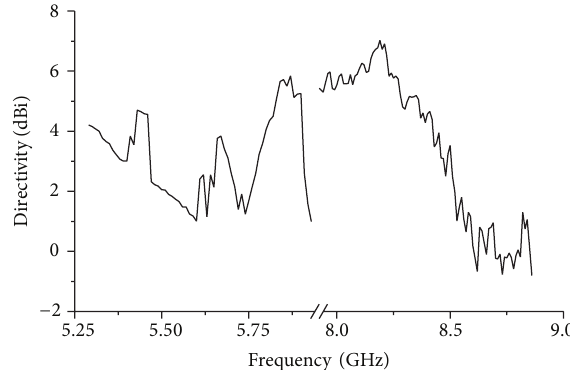
Figure 13: Peak directivity of the optimized dual band resonator.